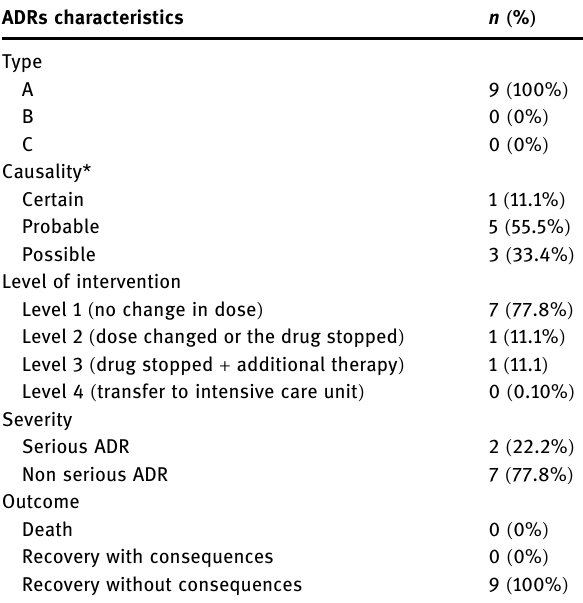
Table 3: Characteristics of detected ADRs associated with clopid - ogrel